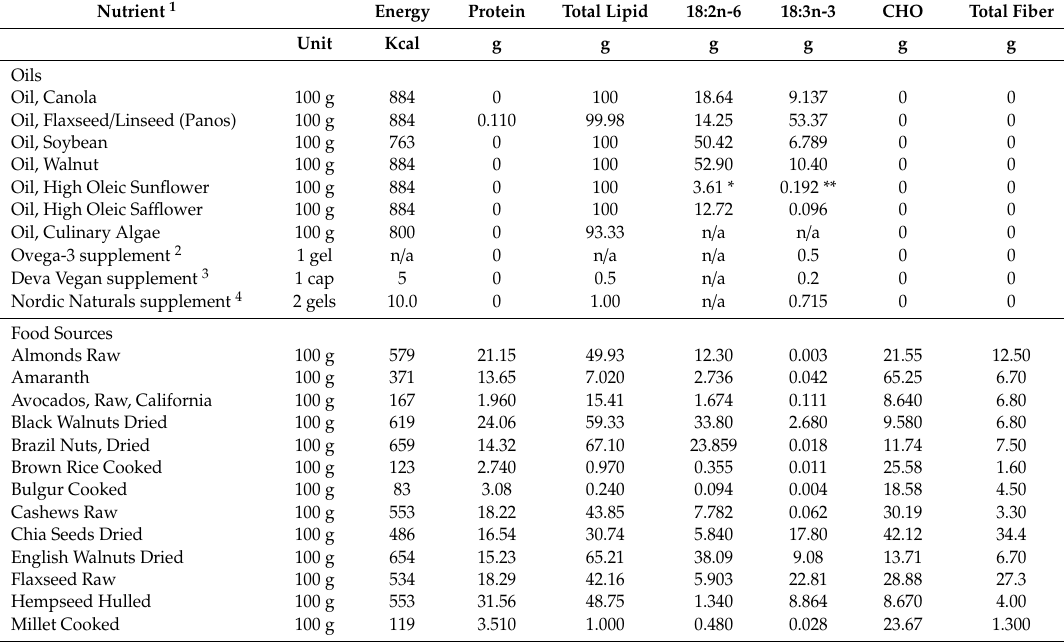
Table 1. Energy, protein, total lipid, 18:2 n-6, 18:3 n-3, carbohydrate, and fiber contents of oils and foods commonly consumed by vegans and vegetarians for the essential fatty